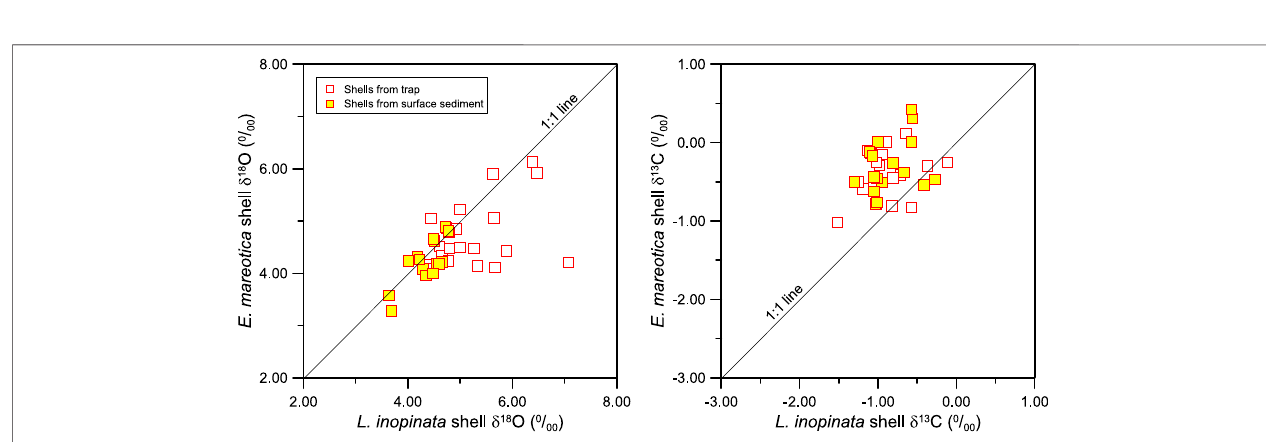
FIGURE 6 | The correlations of (A) δ 18 O and (B) δ 13 C between two species of adult ostracod shells ( L. inopinata and E. mareotica ) from the sediment trap and surface sediment in Lake Qinghai.